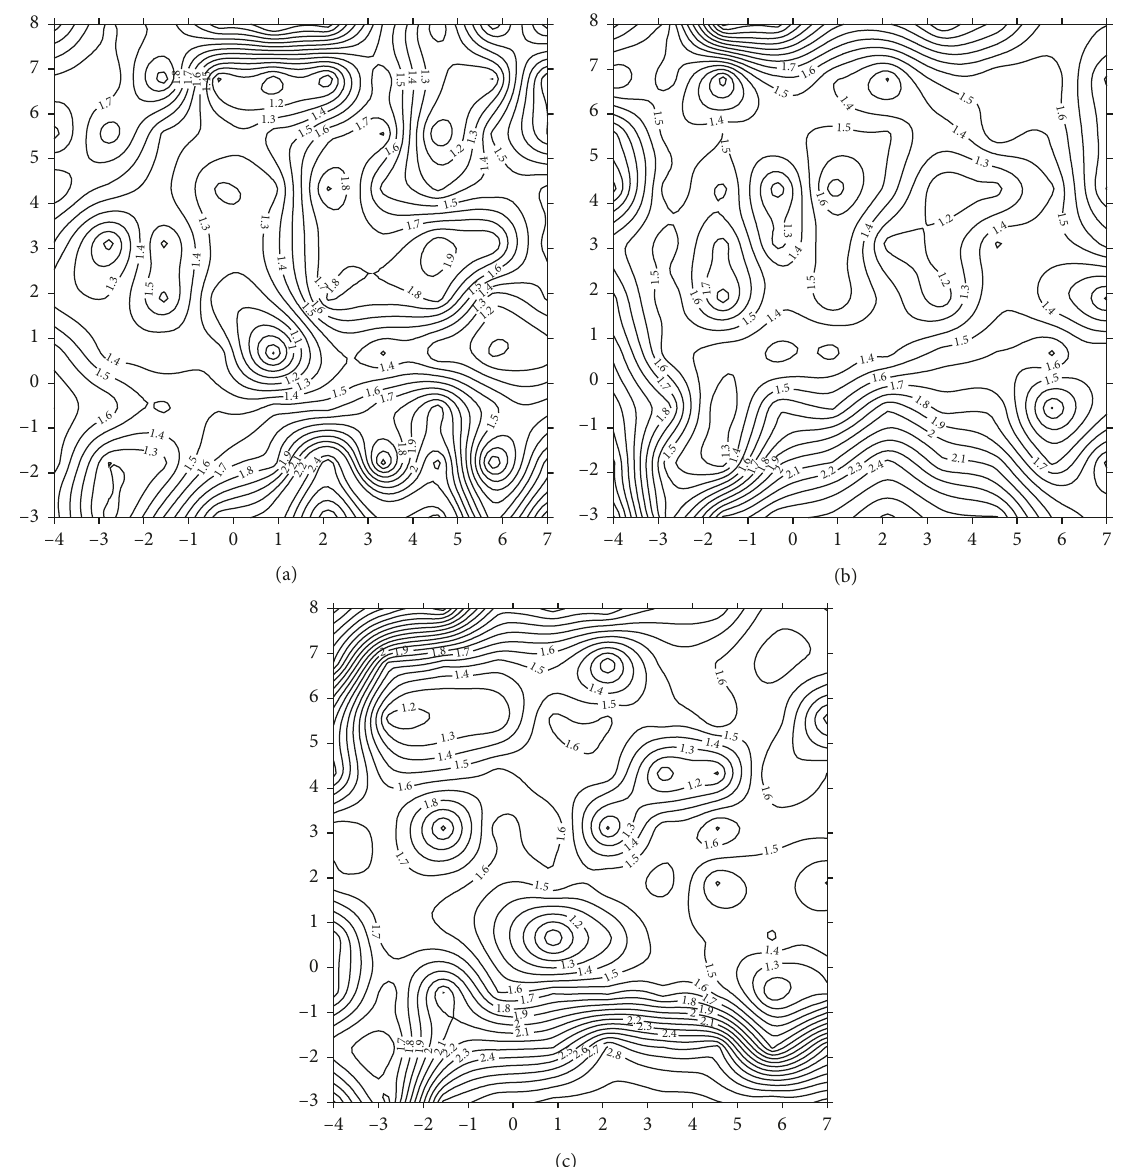
Figure 1: Contour plots of absolute error, the square root of the weighted mean square error, and standard deviation (SD) for a two- dimensional function. (a) Absolute error. (b) The root weighted mean square error. (c) Standard deviation